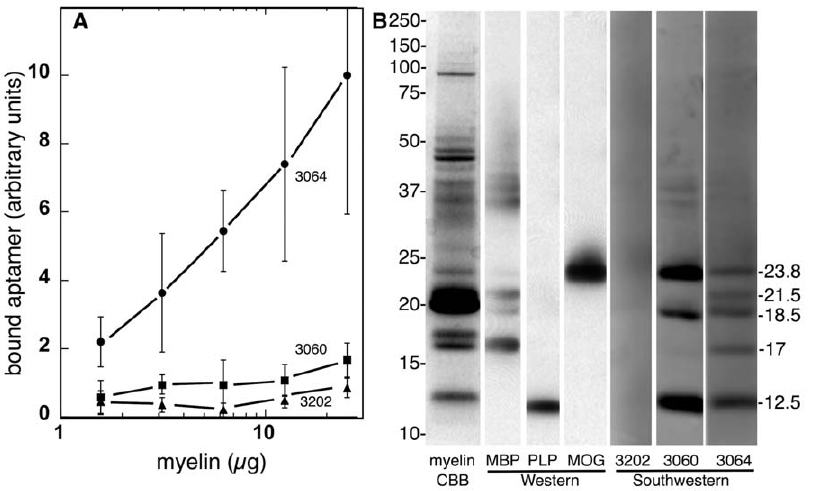
Figure 2. DNA aptamer specificity characterization. A. Binding of fluorescent aptamers 3064 (filled circles), 3060 (filled squares) and 3202 (filled triangles) to crude mouse myelin proteins detected by sedimentation of the insoluble myelin fraction. Mean and standard deviation are shown for three repeats. B. Coomassie staining of crude myelin proteins (myelin; CBB) separated by SDS-polyacrylamide gel electrophoresis and results of western and southwestern blotting with the indicated antibodies or fluorescent aptamers. Mobilities of molecular weight standards are indicated at left and apparent molecular weights of aptamer-reactive proteins are indicated at right.